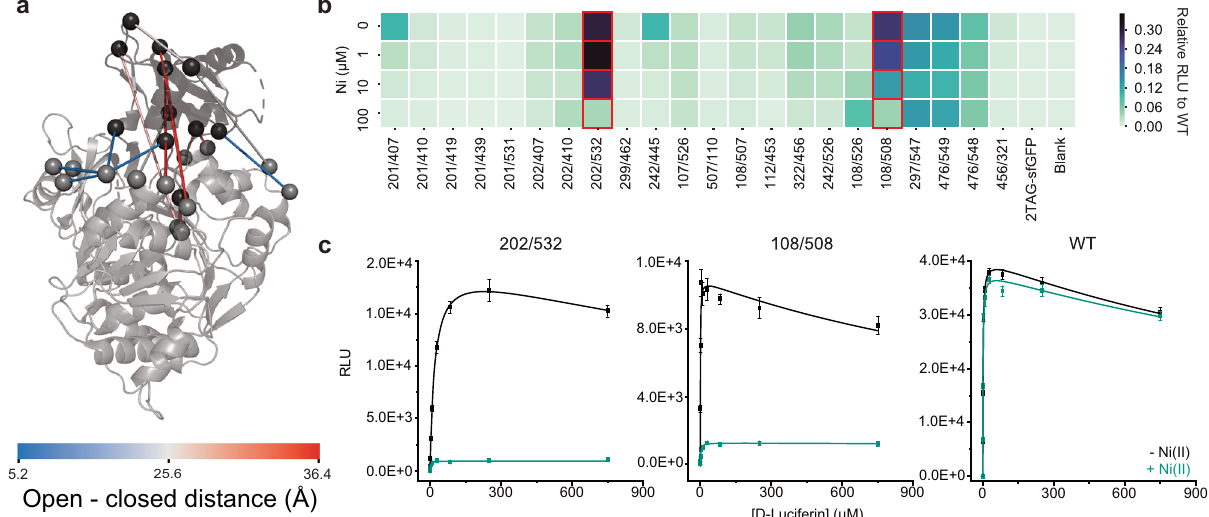
Fig. 5 Implementation of LG-approach in fi re fl y luciferase. a Locations of the fi nal 22 LG pairs selected using the procedure outlined in Fig. 2. b Pluc variants were synthesized using CFPS and activity of D-luciferin oxidation was assessed. Reaction rates (RLU) are shown in response to increasing Ni(II) concentrations (0 – 100 µ M) as a heat map. Inhibited variants are highlighted in red. c Steady-state kinetic assays were performed at room temperature with CFPS-produced enzyme variants Pluc 202/532 , Pluc 108/508 , and Pluc WT in either the absence (black) or presence of Ni(II) (green). Maximum rate (RLU) is plotted versus substrate concentration ( µ M) and data was fi t to a Michaelis-Menten equation that accounts for the observed inhibition using OriginPro. Each data point represents the average of three replicates and error bars represent standard deviations. Source data are provided as a Source Data fi